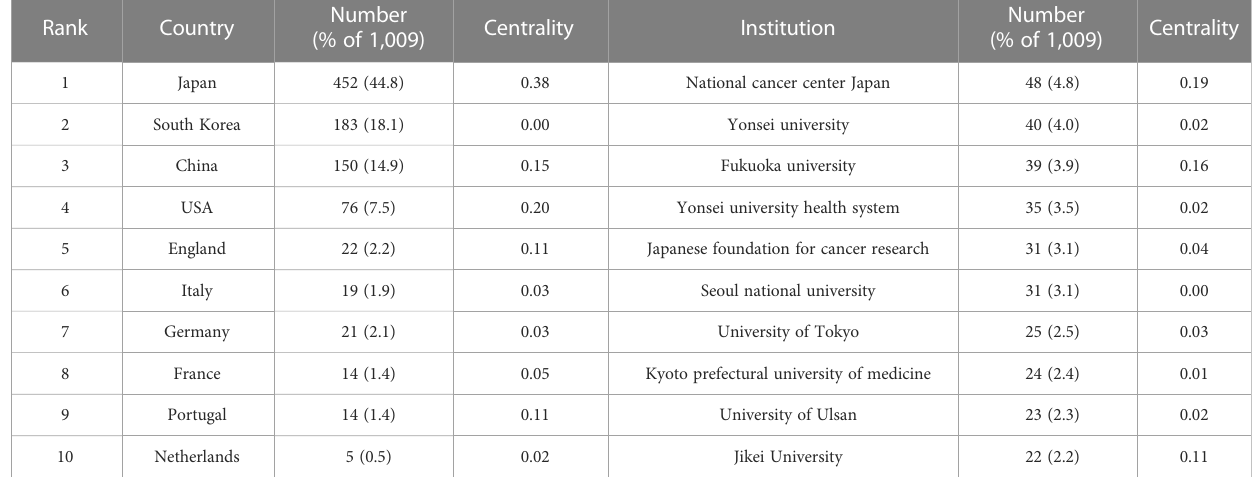
TABLE 2 Top 10 countries and institutions involved in endoscope on EGC.